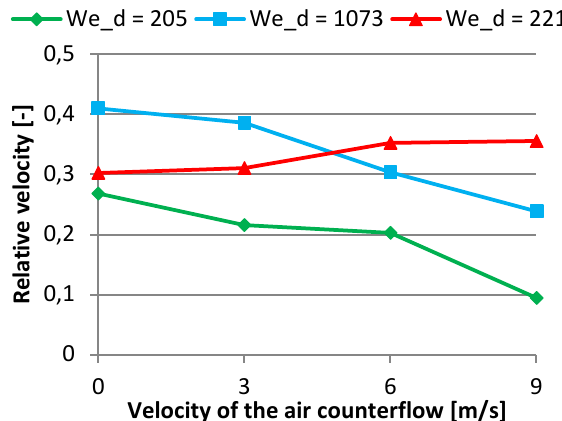
Fig. 7. Influence of the air velocity on the relative velocity of the dispersed liquid for different mother droplets’ Weber numbers .